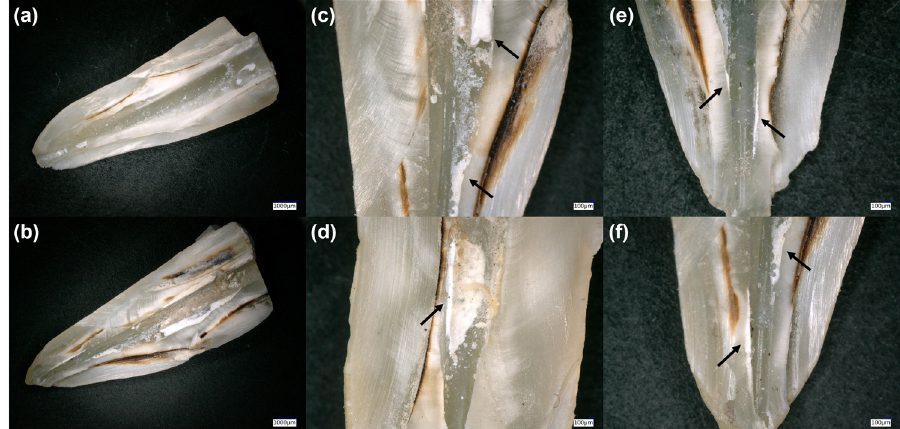
Figure 3. Digital microscope images demonstrate the effectiveness of the retreatment technique and the nature of the residual materials in ( a , b ) the root canal at ( c , d ) the middle and ( e , f ) apical thirds (black arrows).